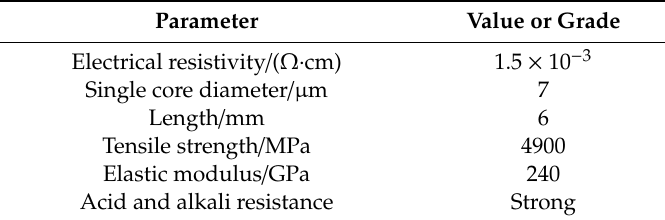
Table 1. Physical-mechanical properties of carbon